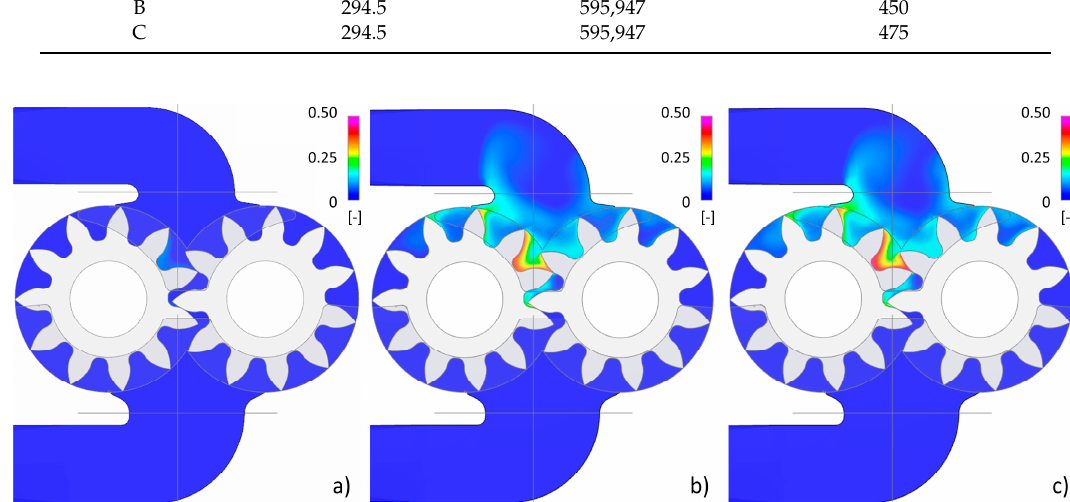
Figure 15. Contour plot of the gas mass fraction for a mid-plane of the tooth width according to three operating points: ( a ) condition A (450 rpm, 293.0 K), ( b ) condition B (450 rpm, 294.5 K) and ( c ) condition C (475 rpm, 294.5 K).